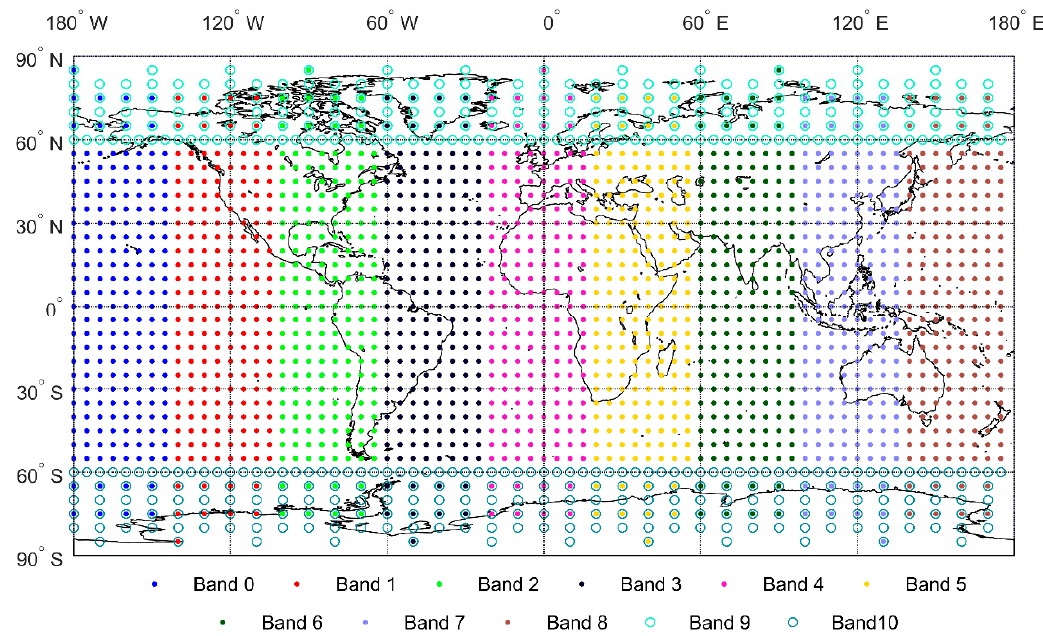
Figure 1. The predefined global ionospheric grid point (IGP) grids.